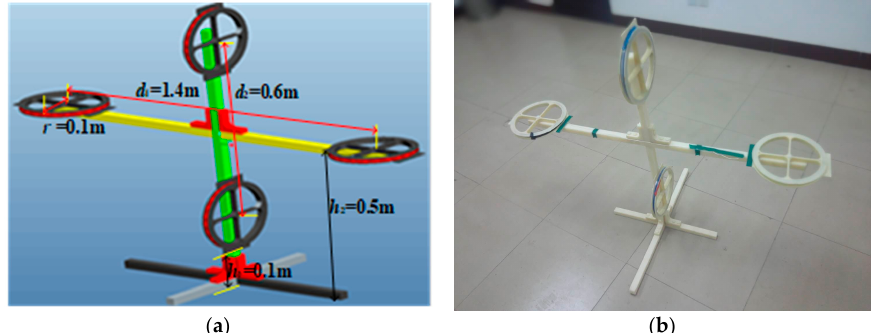
Figure 15. The four-coil device: ( a ) Design diagram and ( b ) finished product.